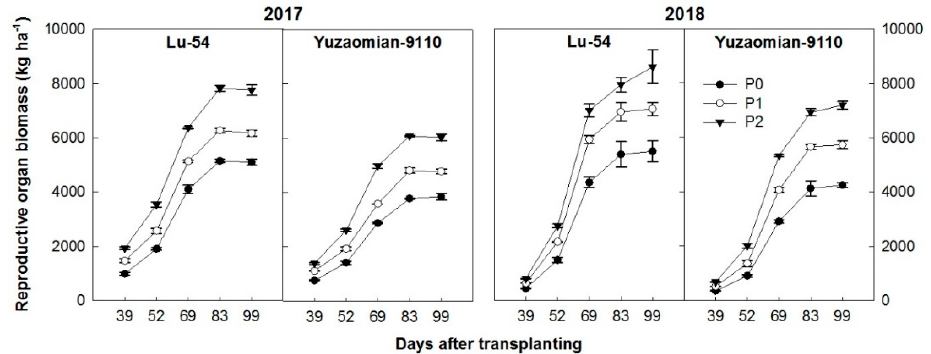
Figure 6. The accumulation of biomass in reproductive organ of cotton plant for Lu-54 and Yuzaomian-9110 in 2017 and 2018. The treatments P0, P1, and P2 represent the P levels, i.e., 0, 100, and 200 kg P 2 O 5 ha − 1 . The data are the means of three replications ± standard error.